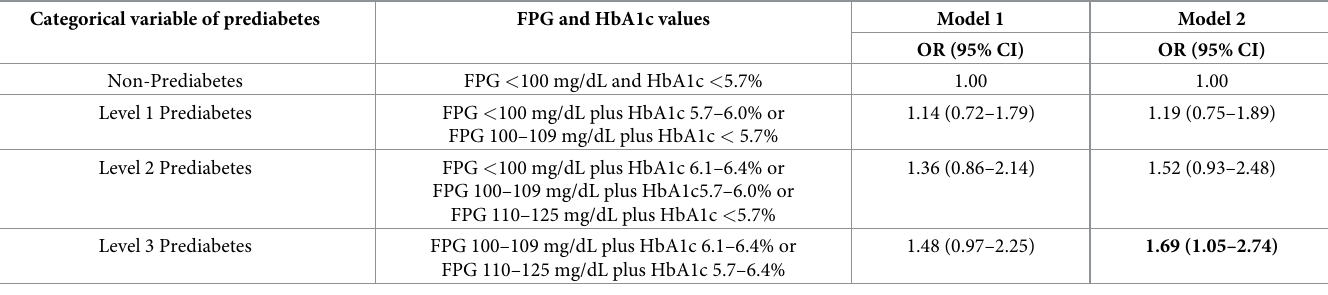
Table 3. Multiple logistic regression analyses for hyperfiltration according to different level of fasting plasma glucose (FPG) and HbA1c (n = 2005). Categorical variable of